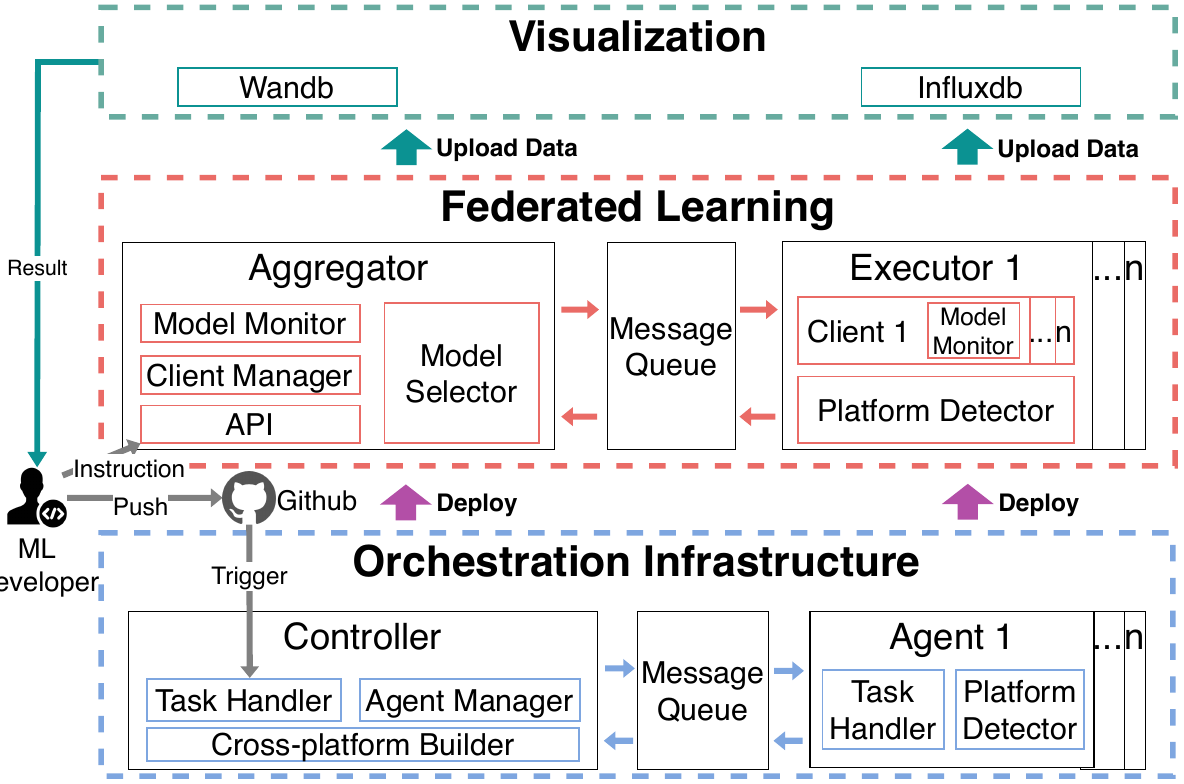
Figure 3. System